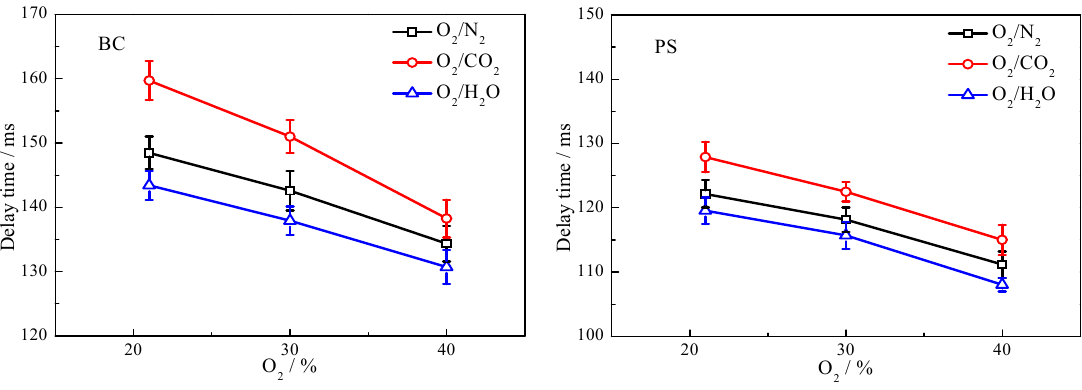
Figure 8. Ignition delay time of BC and PS under different atmospheres.